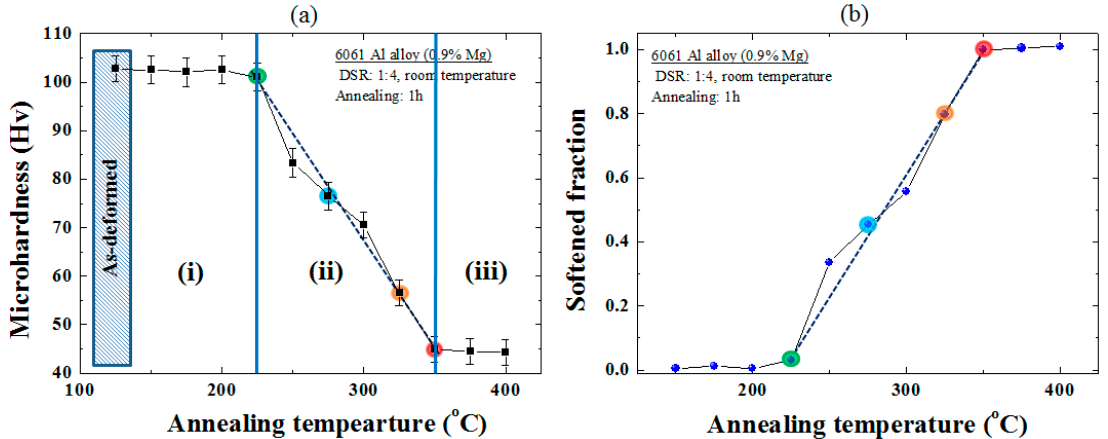
Figure 5. Effect of the annealing temperature on ( a ) microhardness and ( b ) softened fraction of the DSR-deformed 6061 Al alloy. The different color remarks along the dashed line in this figure indicate the annealed samples used to investigate the microstructural evolution during annealing.